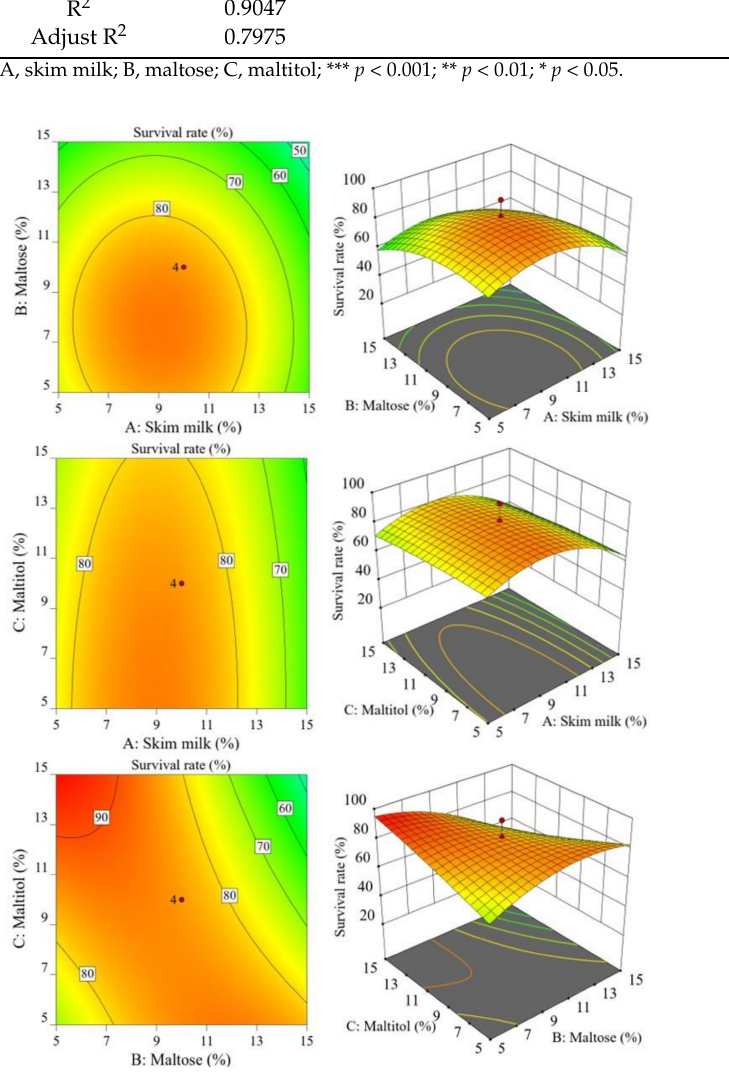
Figure 5. The contour plots and response surface models for the protective effect of selected protec- tants on the survival rate of S. cerevisiae 88-4 after freeze drying. A, Skim milk (%), B, Maltose (%), and C, Maltitol